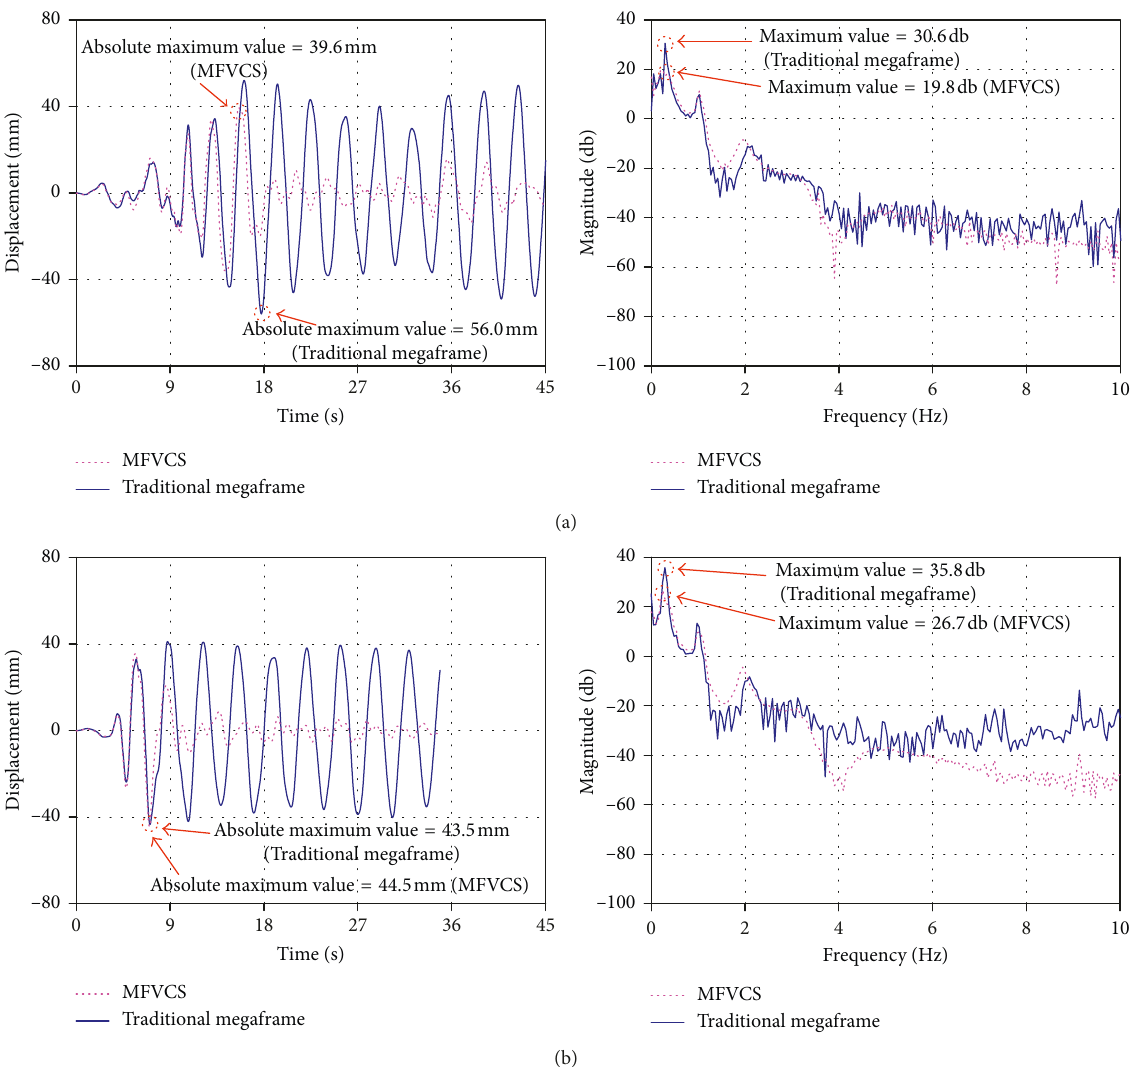
Figure 8: Comparison on the time-history response and corresponding frequency response function between MFVCS and